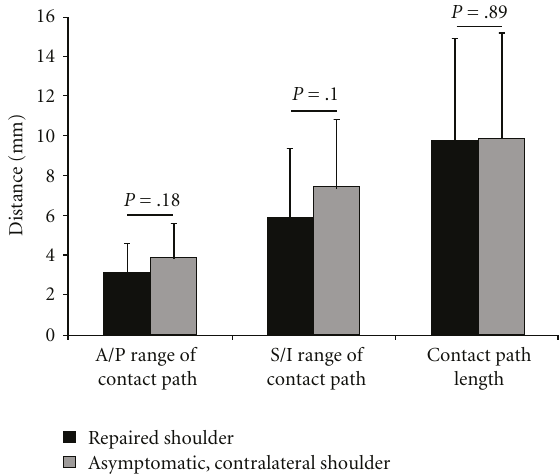
Figure 5: No statistically significant di ff erences were detected between the repaired and contralateral shoulders in terms of A/P contact center position range ( P = . 18), S/I contact center position range ( P = . 10), or contact path length ( P = .